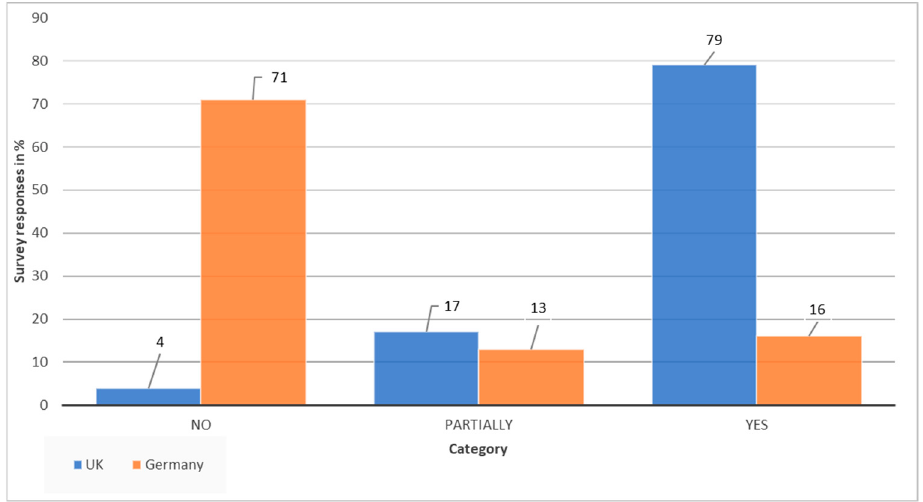
Figure 2. Comparison of UK and German participants with sustainability in their job description.